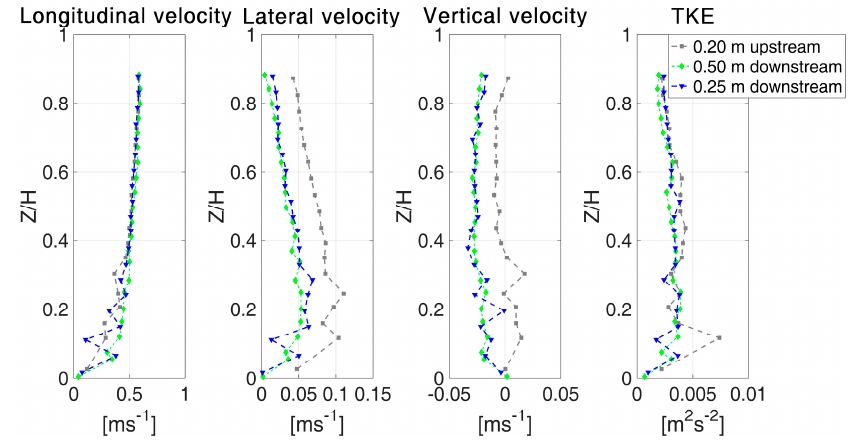
Figure 9. Profiles from the Jeziorka River upstream and downstream of P. pectinatus .